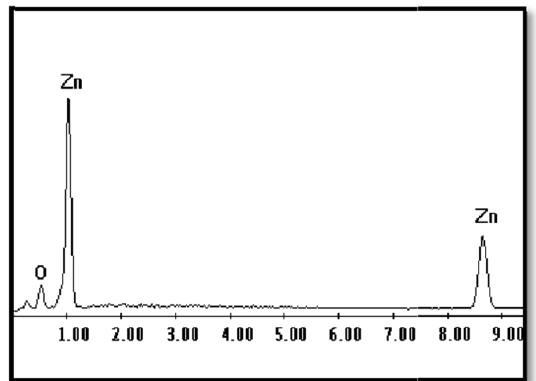
Figure 1. Elemental analysis (chemical composition) of zinc oxide nanofertilizers (NfsOZn) by energy dispersive X-ray (EDX).